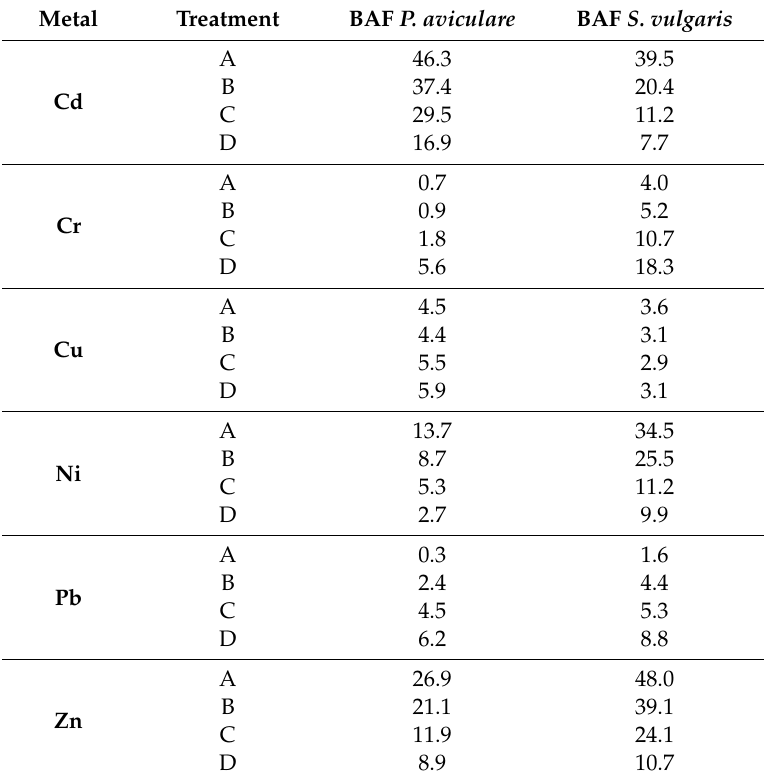
Table 1. Bioaccumulation factors in P. aviculare and S. vulgaris. Each value is the average of the data all data. Metal Treatment BAF P. aviculare BAF S.